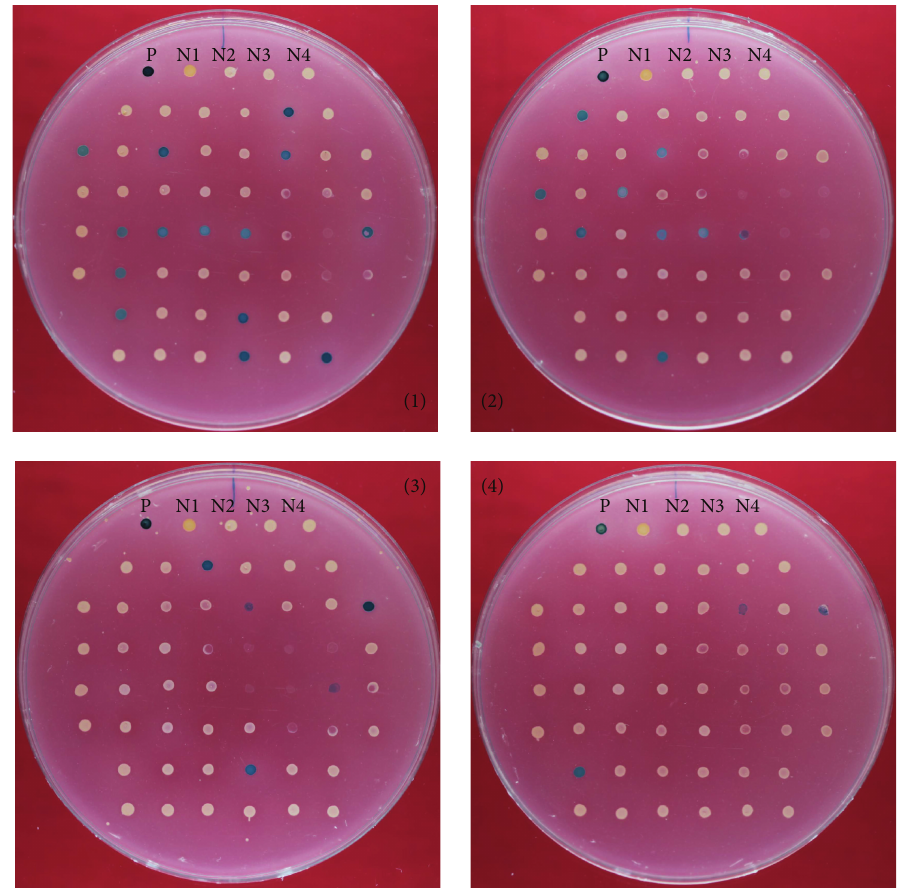
Figure4:Expressionof bgaH geneinJ7-2-1viatheintegrativeplasmidpUC19-HM1752- bgaH .TheplasmidpUC19-HM1752- bgaH containing bgaH was transformed into strain J7-2-1. In total, 200 transformants were picked out randomly and cultured. The activity of 𝛽 -galactosidase in these 200 transformants was detected on four MGM plates (50 transformants on each plate) supplied with X-gal (detailed process is discussed in Materials and Methods). If the transformants had 𝛽 -galactosidase activity, the color of the corresponding colony would turn blue. The results were recorded and pictures taken after the four plates were stored at 42 ∘ C for 7–15 days. P: positive control. N1: negative control Hfx. volcanii DS52. N2: negative control J7-2-1. N3: negative control J7-2-1 transformed with J7-2 genome. N4: negative control J7-2-1 transformed with KM1752